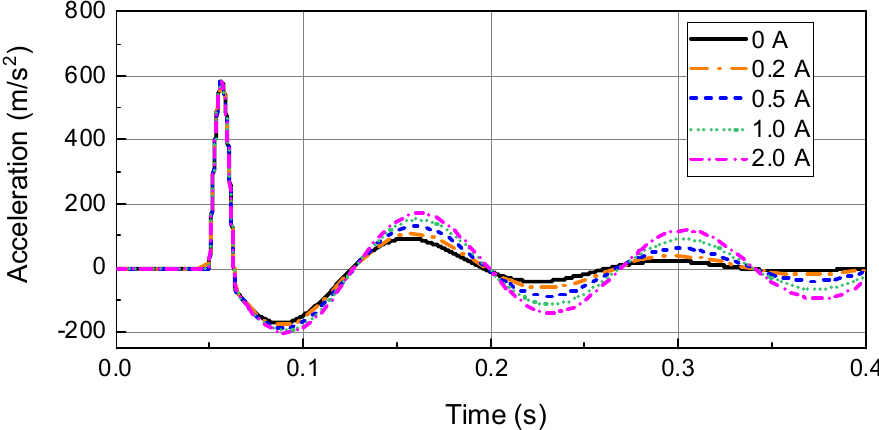
Figure 12. GUI of the waveform prediction simulator program: ( a )Flow chart; ( b ) GUI program.